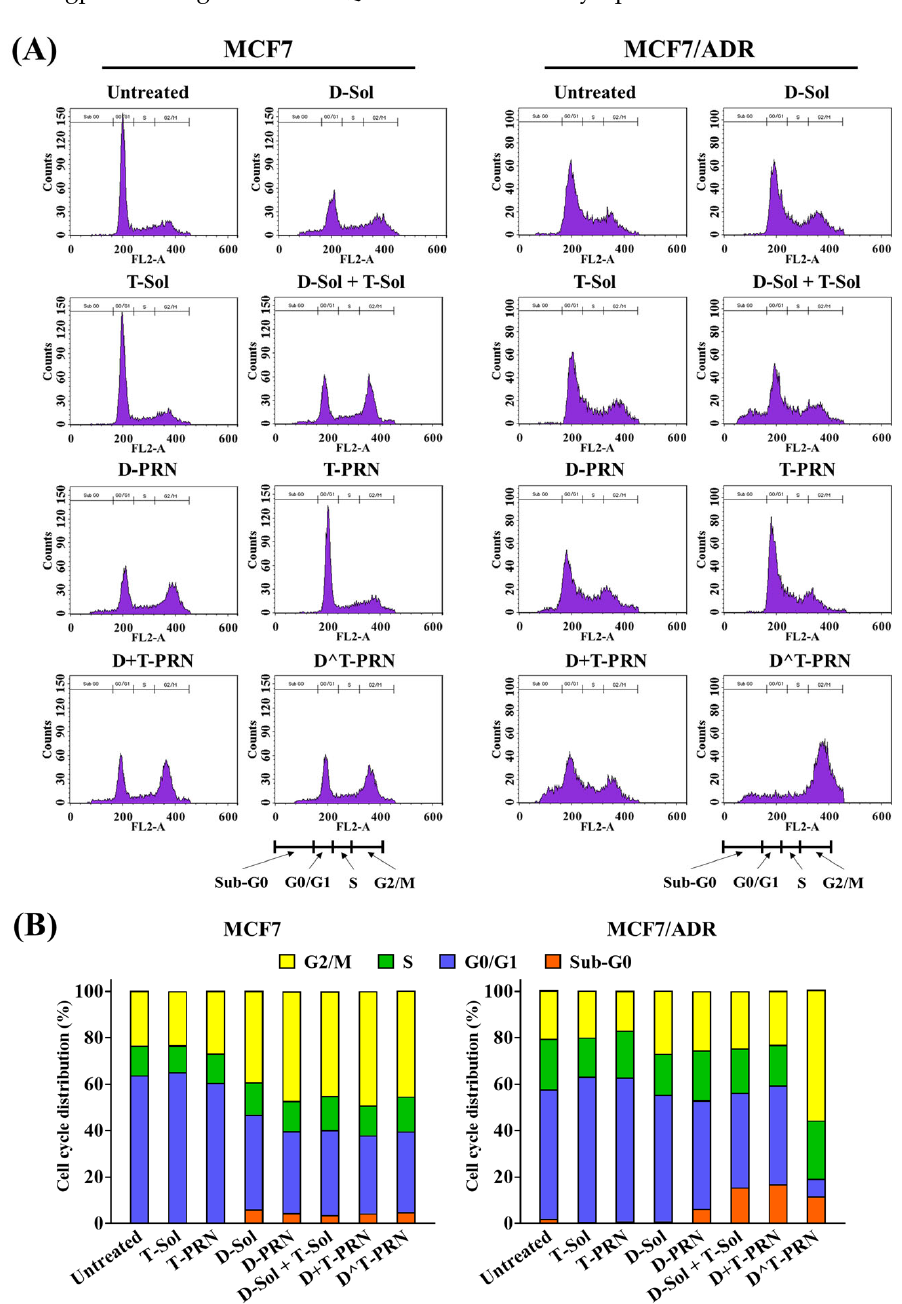
Figure 4. Effect of 24 h treatment with docetaxel (DTX)- and/or tariquidar (TRQ)-loaded formulations on the cell cycle of MCF7 and MCF7/ADR cells. ( A ) FACS histogram of the cell cycle and ( B ) quantitative analysis of cell-cycle arrest.